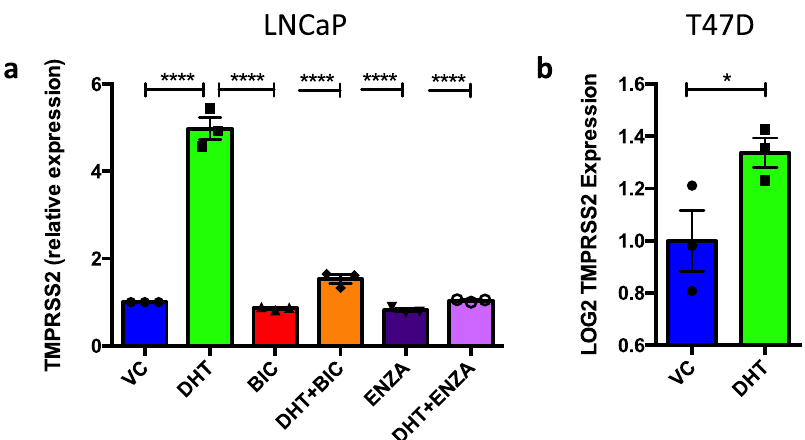
Fig. 1 TMPRSS2 is an androgen-regulated gene in cells from different tissues. a LNCaP cells were incubated in hormone-depleted media for 72 h and treated with ±10 nM dihydrotestosterone (DHT) ± 10 μ M bicalutamide (BIC) or enzalutamide (ENZA) for 6 h. RNA was harvested, reverse transcribed and qPCR performed to quantify TMPRSS2 expression. Mean of three independent repeats (±1 SEM). One-way ANOVA with Tukey ’ s multiple comparison test **** Vehicle Control (VC) v DHT – p = 8.6 × 10 – 11 , DHT v BIC – p = 4.9 × 10 – 11 , DHT v DHT + BIC – p = 7.3 × 10 – 10 , DHT v ENZA – p = 4.0 × 10 – 11 , DHT v DHT + ENZA – p = 1.0 × 10 – 10 . b Data from T47D cells (GSE62243, N = 3) 39 treated with 10 nM DHT were analysed for TMPRRS2 expression. One-tailed t -test, * p = 0.0302. Source data are provided as a Source Data fi